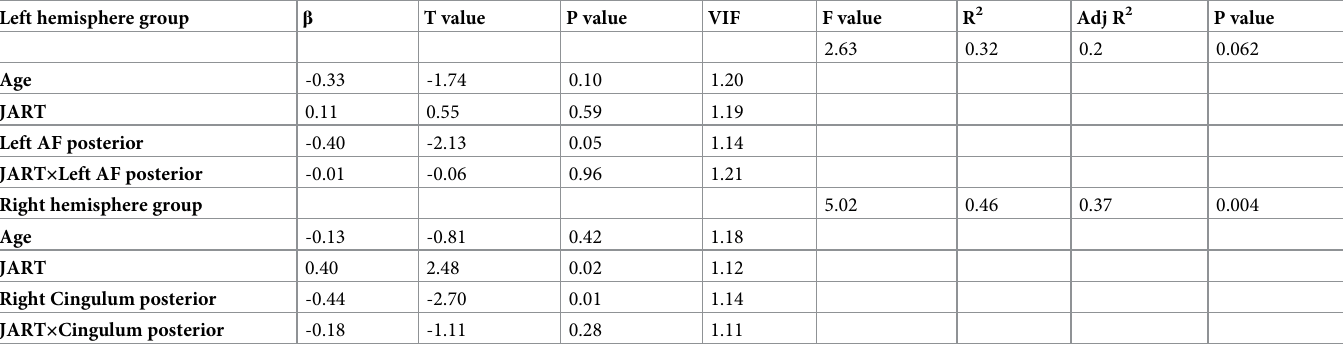
Table 3. The interaction effects on postoperative VSTM.